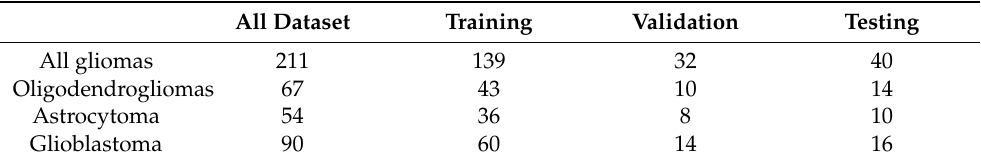
Table 1. Summary of dataset.